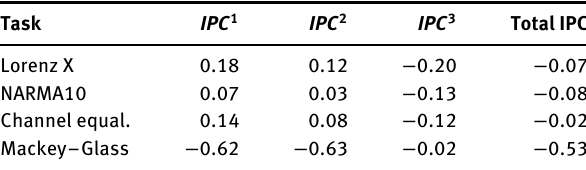
Table 2: Pearson correlation coefficients between the information processing capacities (IPC) (plotted in Figure 3) and the benchmark task NMSE errors (plotted in Figure